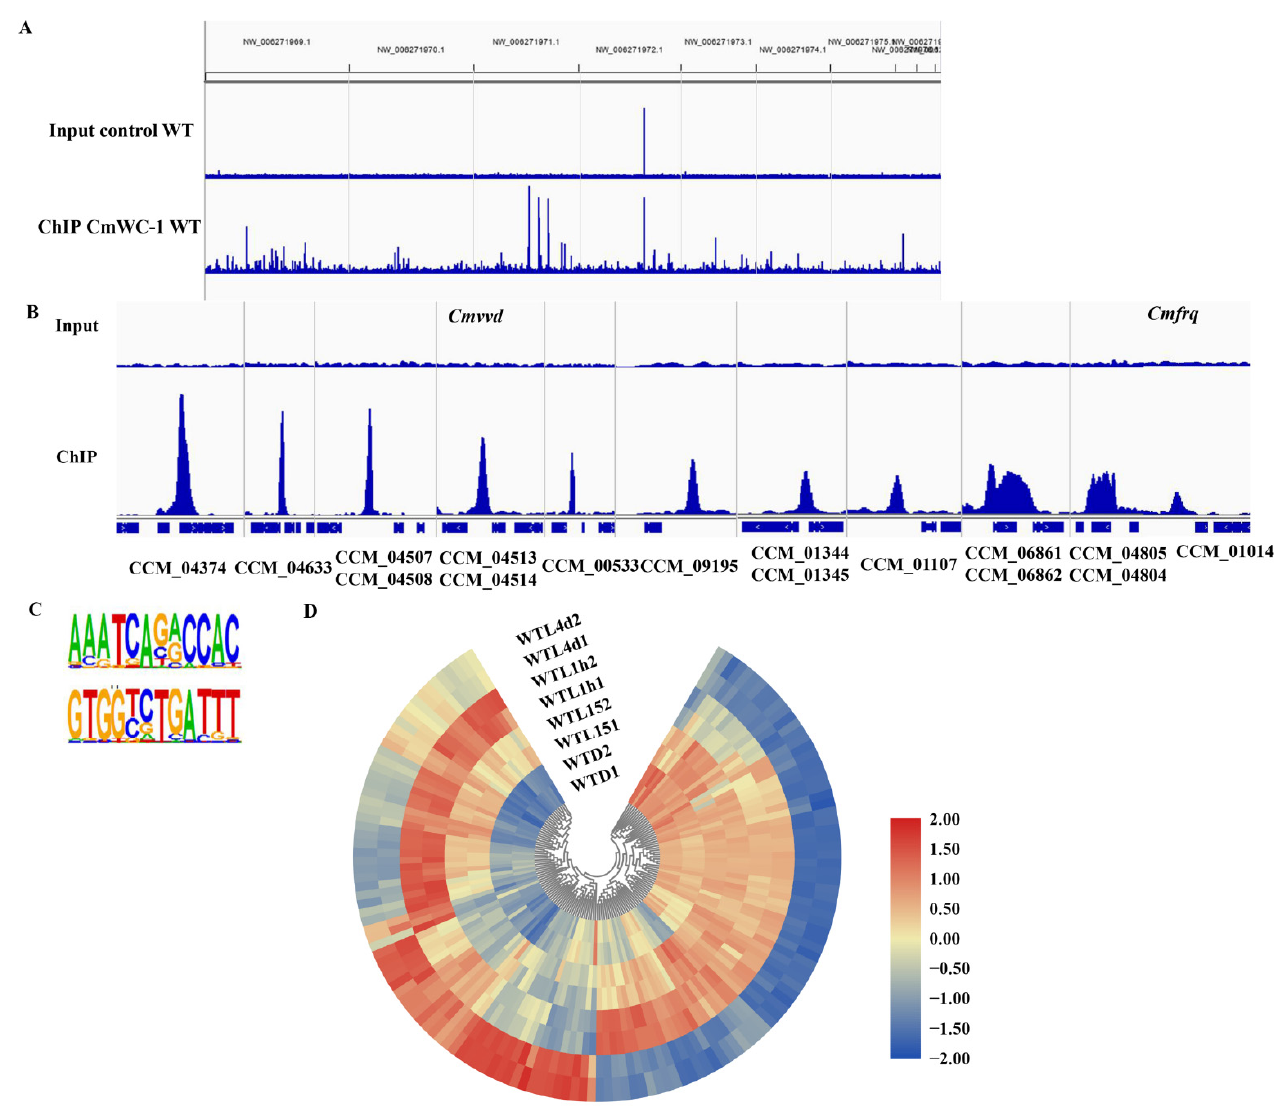
Figure 7. Genome-wide ChIP-seq analysis identified direct transcriptional targets of CmWC-1 in response to light for 15 min. Genome-scale view of ChIP-seq data for the ChIP sample. Blue lines rising above background are peaks identified as an excess of sequence fragments aligning to the genome of Cordyceps militaris strain CM01. The genome-wide view of the ChIP-seq reads aligned to the CM01 genome reveals strong visible peaks in the CmWC-2 antibody ChIP sample. Grey lines demarcate genome scaffolds ( A ). ChIP-seq peaks for selected genes including Cmvvd (CCM_04514) and Cmfrq (CCM_01014) ( B ). CmWC-1 binding motif identified using Homer ( C ). Gene expression of differentially expressed genes among the target genes of CmWC-1 obtained by ChIP-seq ( D ).